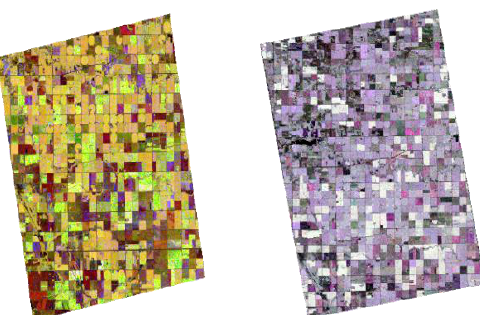
Figure 4 . Freeman- Durden and Paulie